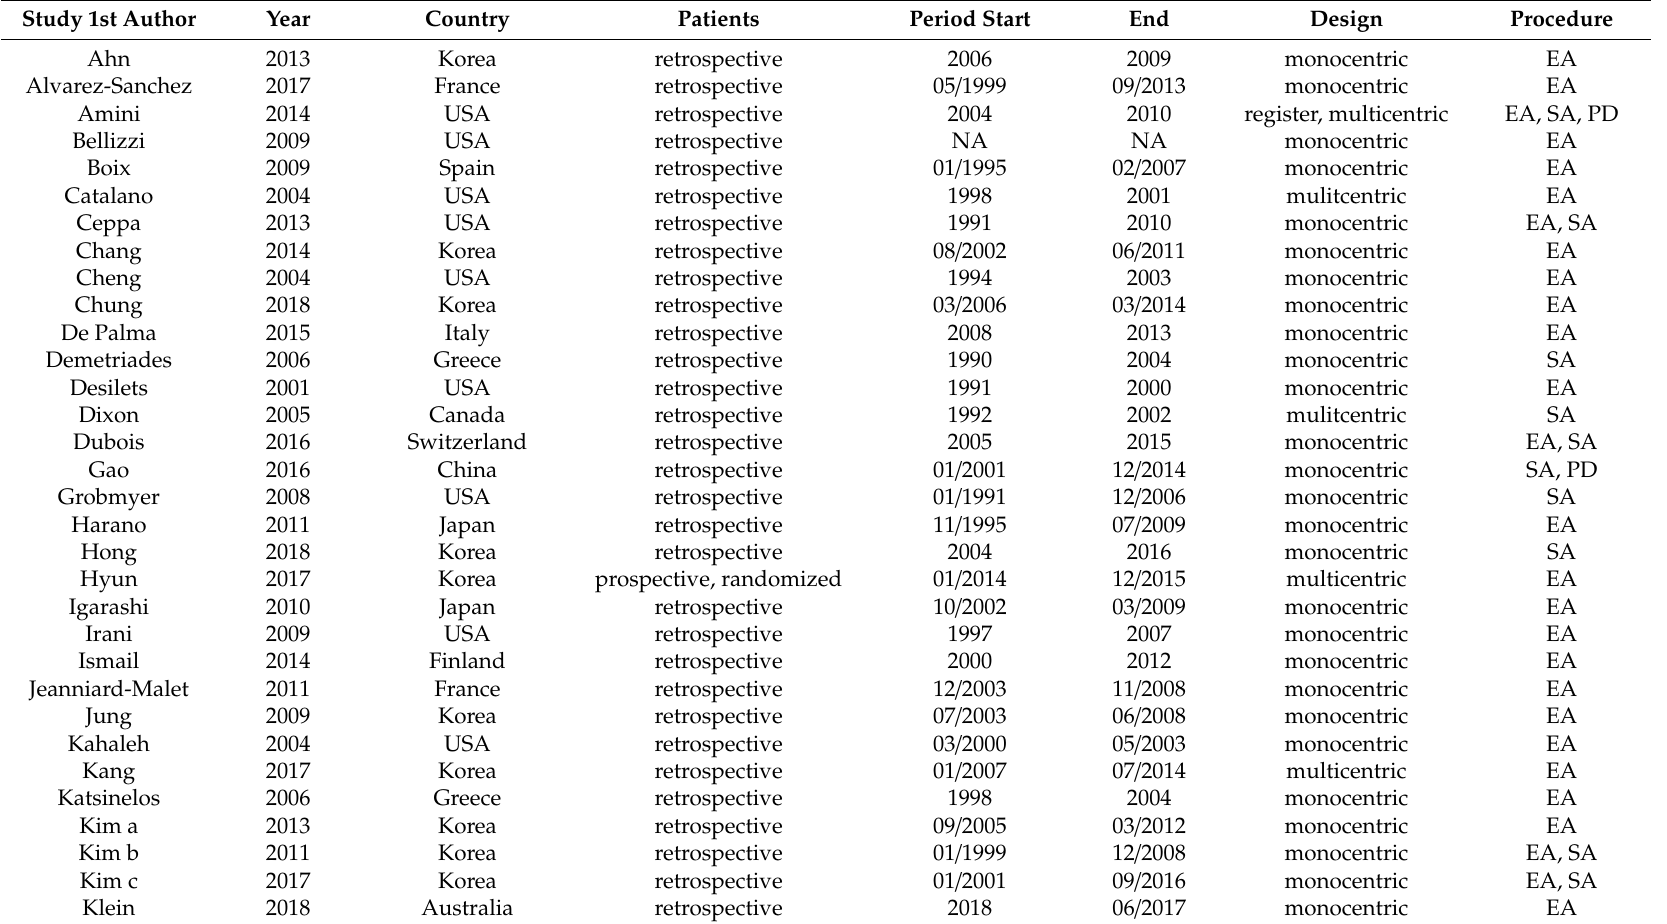
Table 2. Characteristics of the included